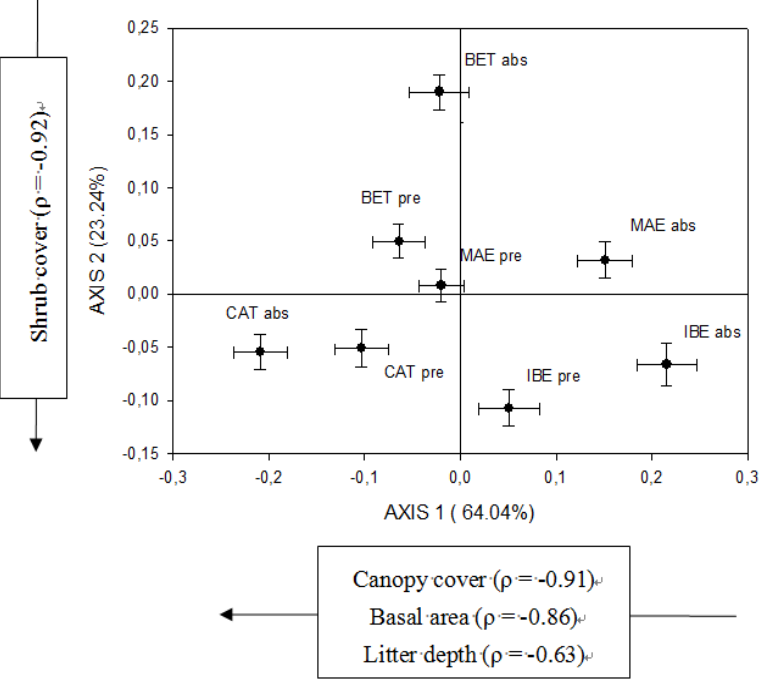
Figure 4. Canonical discriminant analysis of principal coordinates of the stand-structural variables characterizing the sites where P . nigra subsp. salzmannii seedlings are present (pre) or absent (abs) in the four study regions (CAT, MAE, IBE, and BET). Data are means ± standard errors ( n =